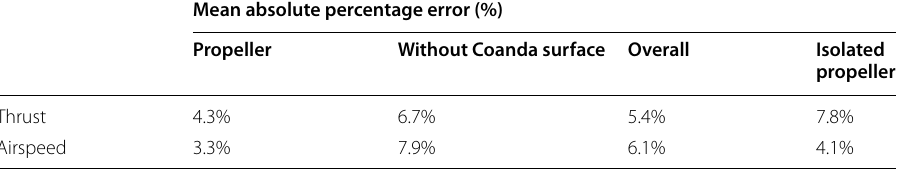
Table 2 Thrust and airspeed MAPE results for all four loading conditions